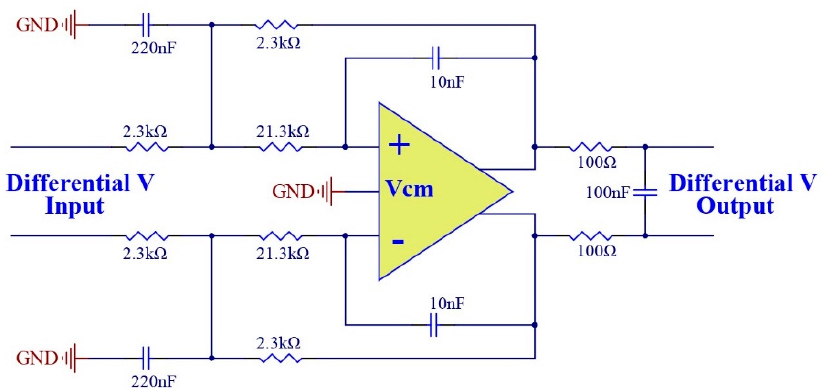
Figure 5. Third-order low-pass Butterworth differential antialiasing filter.